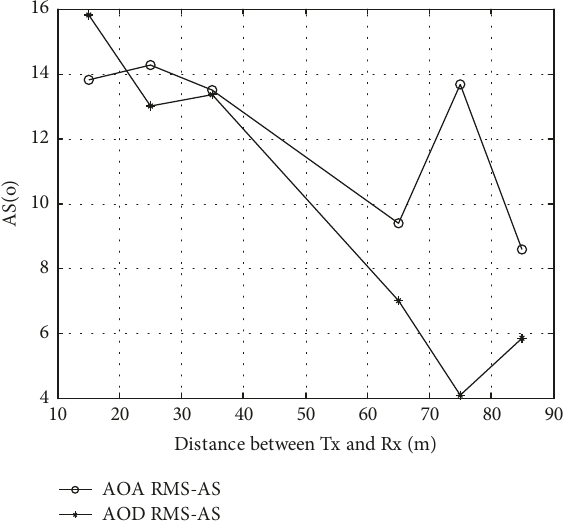
Figure 18: RMS-AS of AOA and AOD versus link